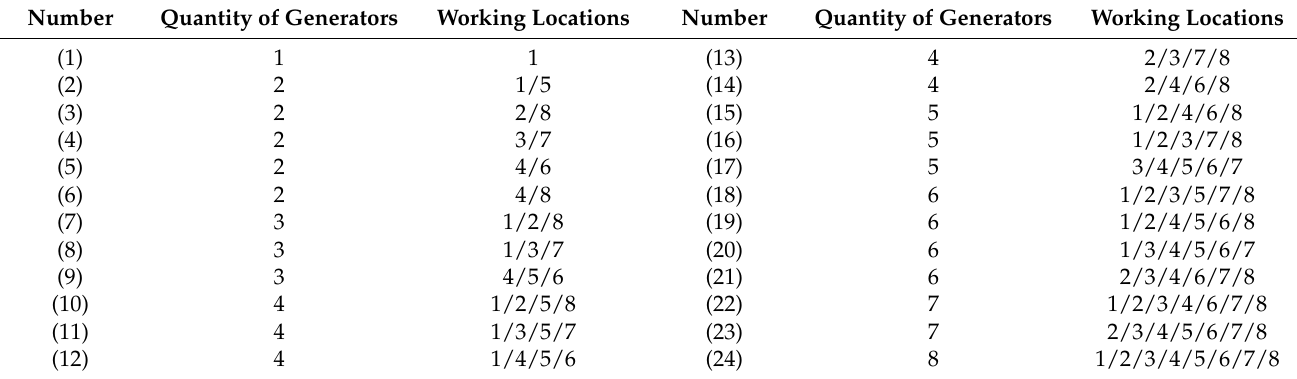
Table 1. Setting methods of the microwave